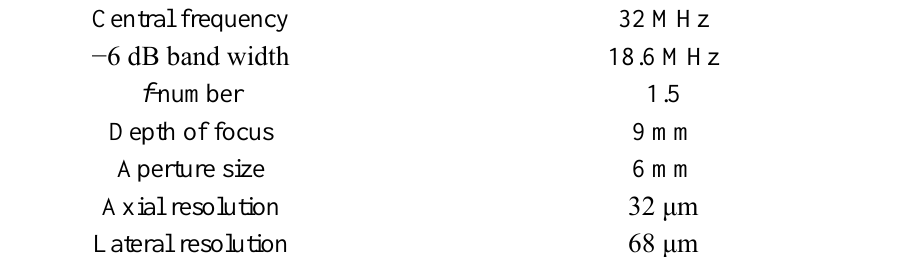
Table 1. Characteristics of the applied